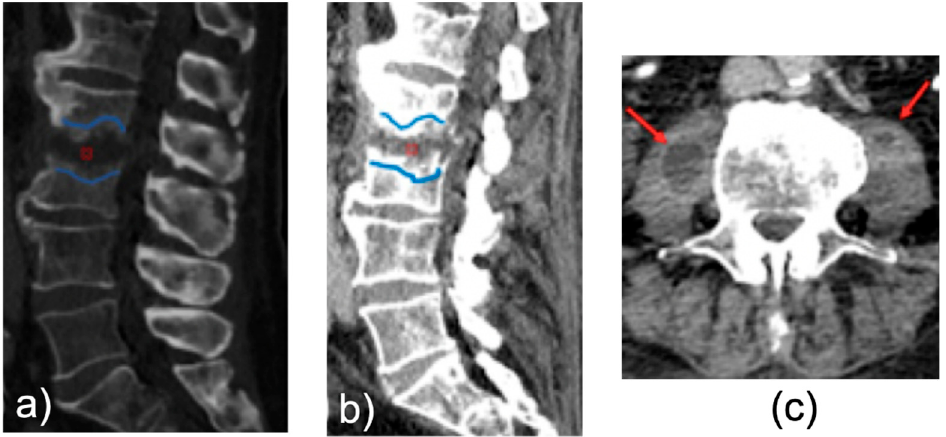
Figure 3. Sagittal CECT reconstruction in bone ( a ) and soft tissue ( b ) window, and axial CECT reconstruction in soft tissue window ( c ) show in L2-L3 level: moderate subchondral bone erosions of the end plates (( a , b ), blue curvilinear lines) and strong enhancement of the subchondral bone of the end plates (( b ), blue curvilinear lines), without significant densitometry changes in the disc (( a , b ), red point) but with evident muscle abscesses of the ileus psoas muscles, especially on the right (( c ), red arrows). CECT was suspicious for spondylodiscitis, confirmed by positive blood cultures. Table 4. Diagnostic findings of spondylodiscitis on MDCT in 15 segments (13 patients). Finding erosive bone changes